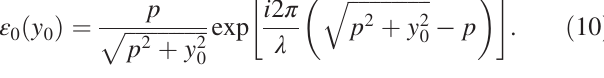
FIG. 4. Minimum σ obtained from three methods; see the text for details. The dot- dash line indicates σ